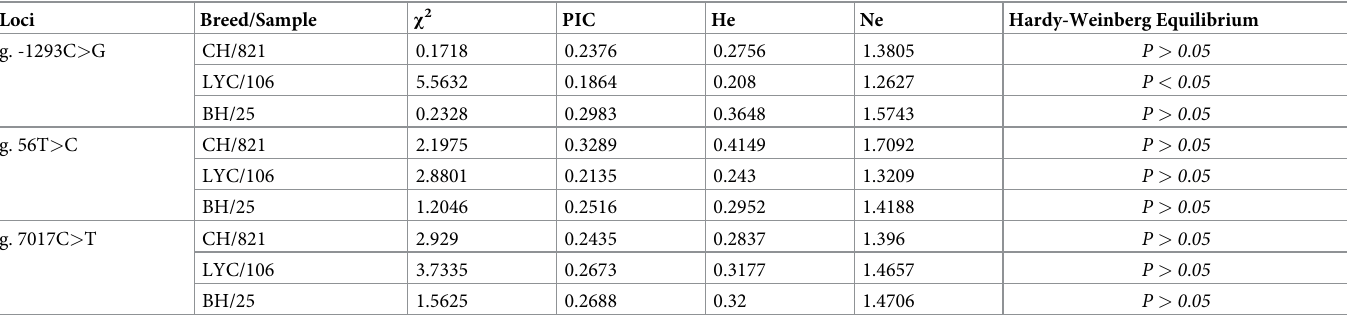
Table 4. χ 2 tests, heterozygosities (He), effective number of alleles (Ne) and polymorphism information contents (PIC) of C3 gene of three breeds.